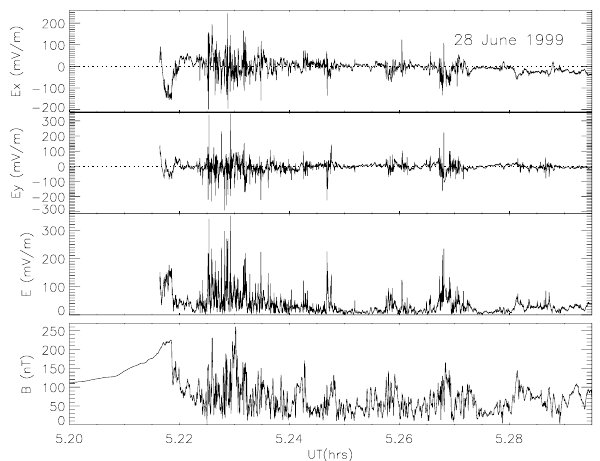
Fig. 4. The time variations of the cusp electric field (Top three pan- els), and the local magnetic field strength (bottom) measured by POLAR at 05:12:00–05:17:42UT on 28 June 1999.